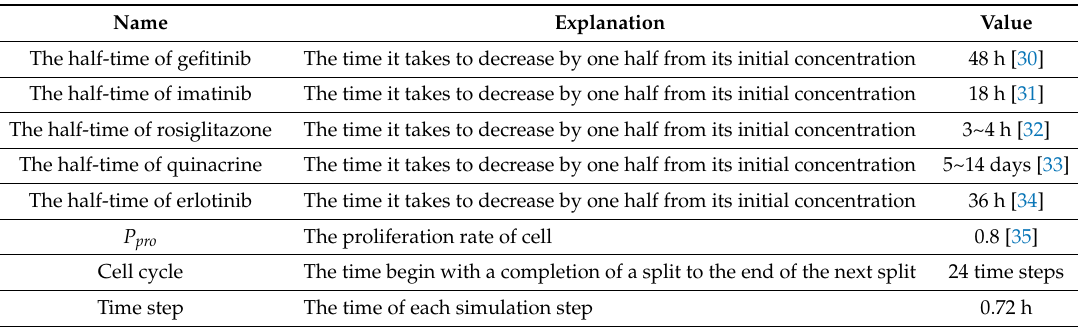
Table 1. System identified parameters.